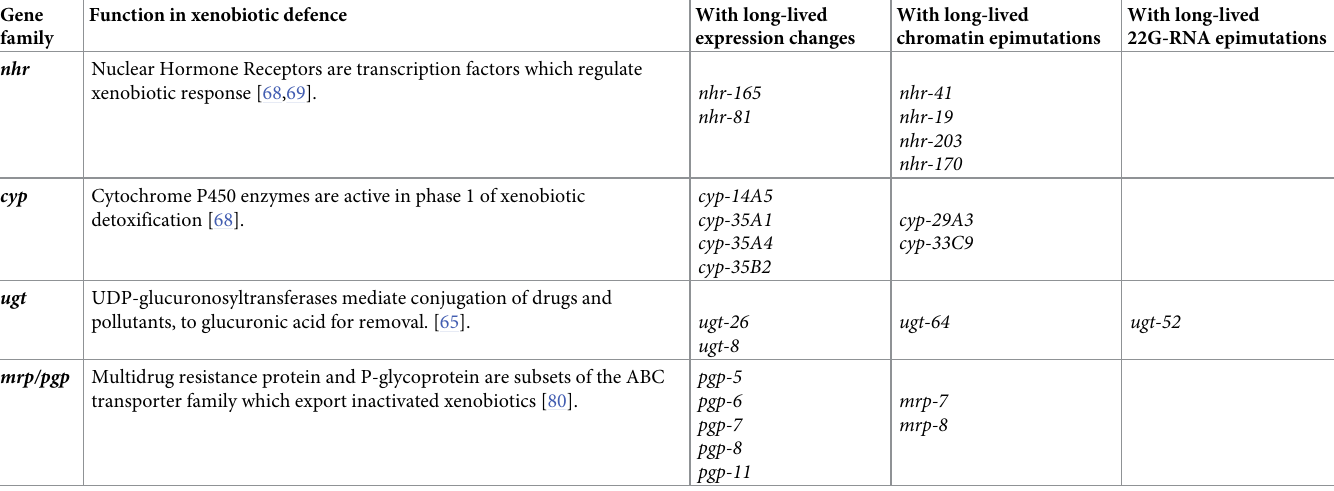
Table 3. Four gene families with critical roles in xenobiotic defence have long-lived epimutations. Xenobiotic defence genes are represented in the subset of genes with long-lived expression changes and long-lived chromatin-based epimutations but only one such gene had long-lived 22G-RNA-based epimutations.